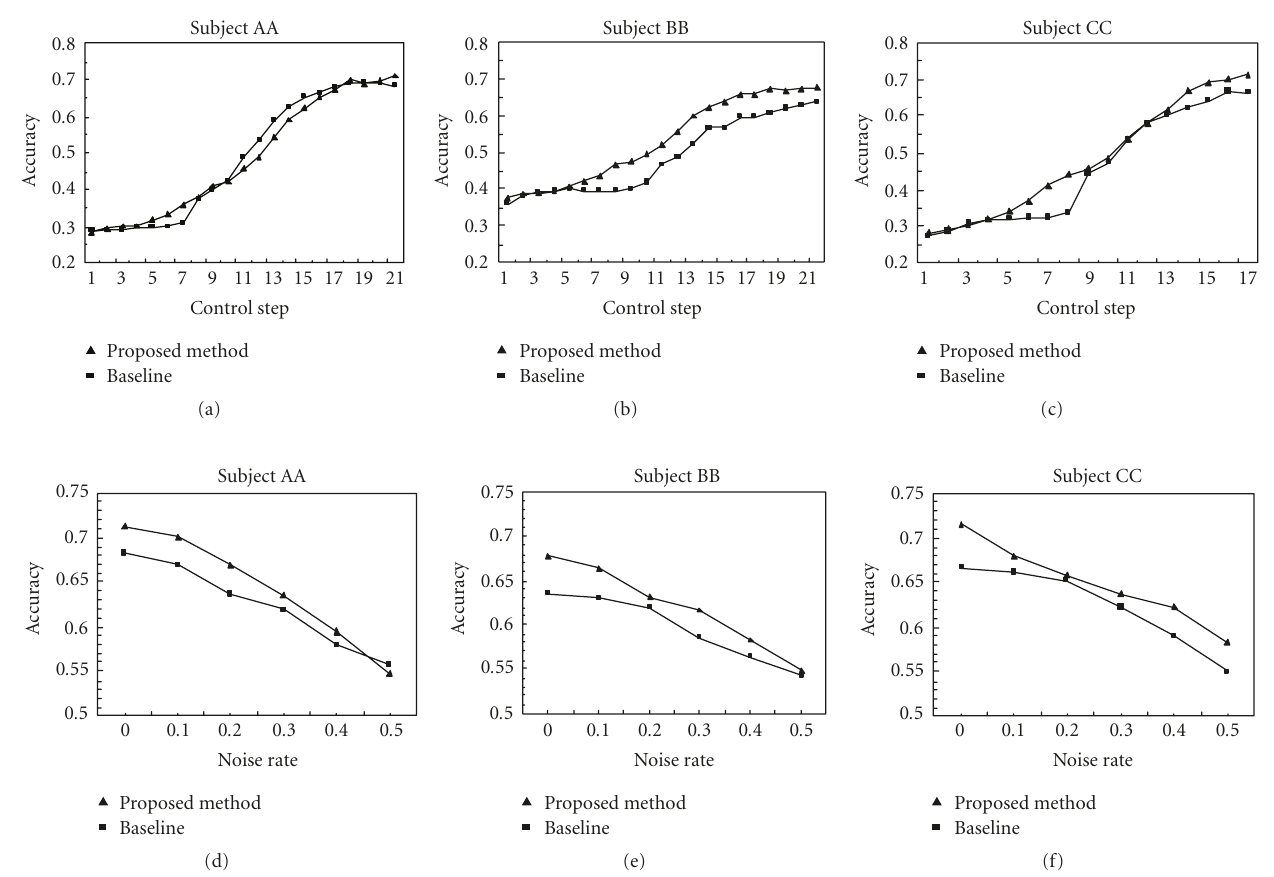
Figure 5: We further study the e ffi cacy of the proposed algorithm in two aspects. At the top, we compare the control performance between the proposed method ( (cid:2) ) and the baseline ( (cid:3) ). At the bottom, the classification accuracies at di ff erent noise rates are